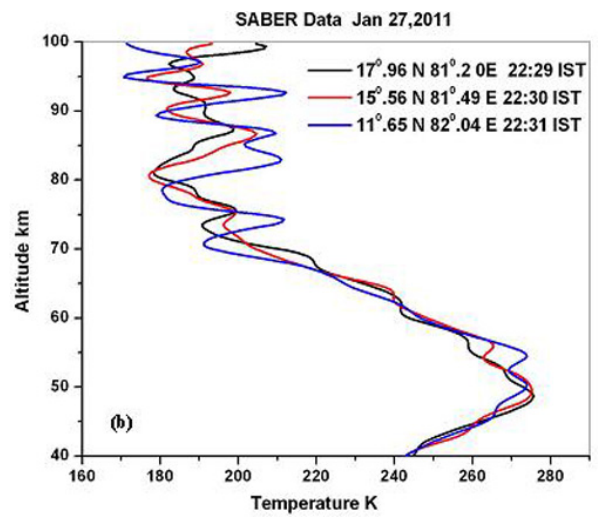
Fig. 3b. The standard deviations for hourly averaged temperature profiles (on 6 January 2011) with improved (red lines) and tradi- tional (black lines)